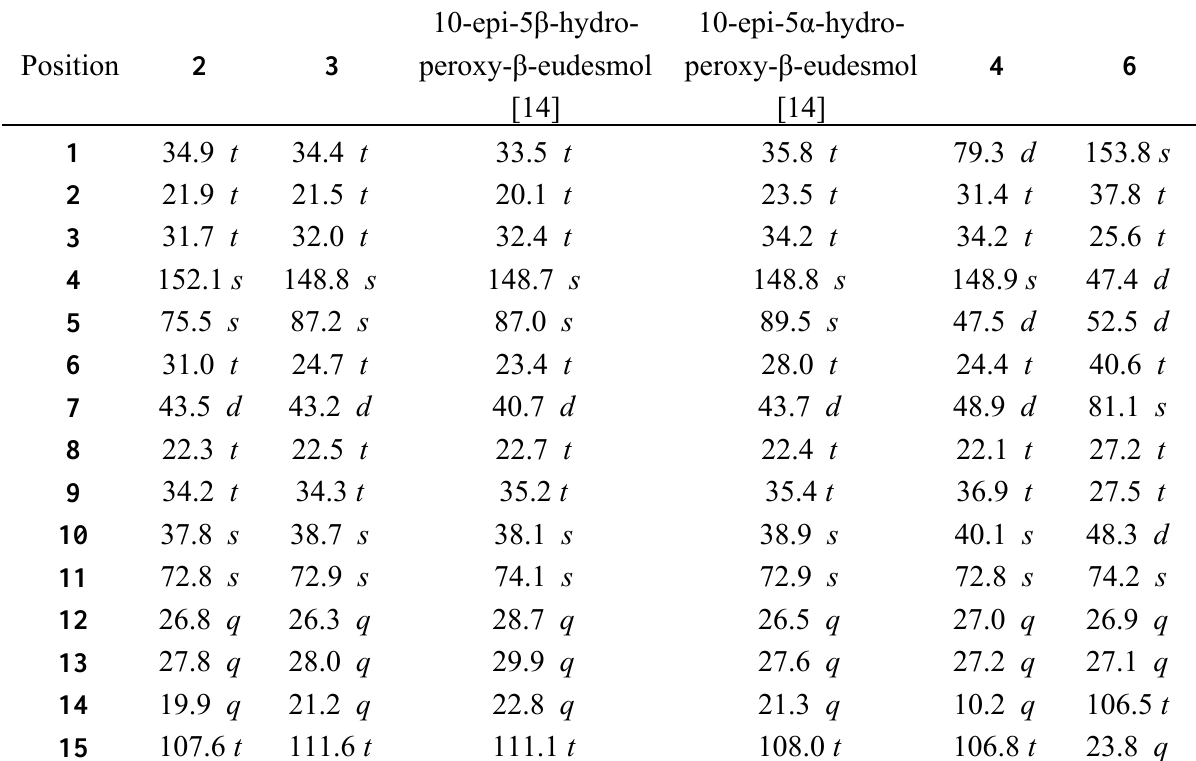
Table 1. 13 C-NMR spectral data of 2, 3, 4, 6 a and related